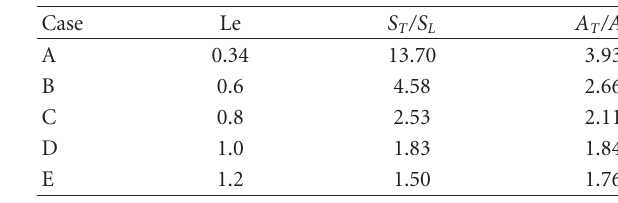
Table 2: The e ff ects of Lewis number on normalised turbulent flame speed S T /S L and normalised flame surface area A T /A L after 3.0 initial eddy turn over